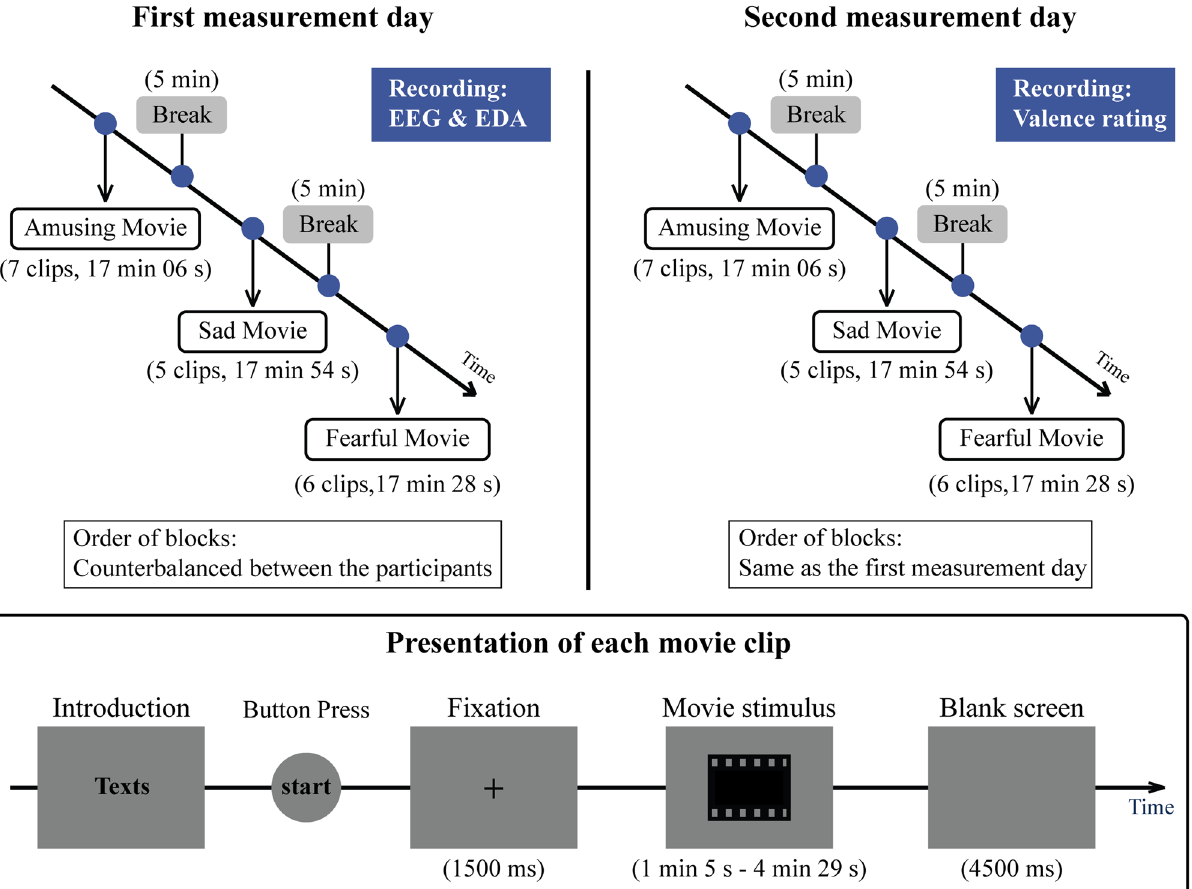
Figure 5. Experimental design. Psychophysiological and behavioural measurements were conducted for every participant on two separate days. Clips in the same emotional category were presented randomly. EEG electroencephalography; EDA electrodermal activity. EEG is not reported in the present